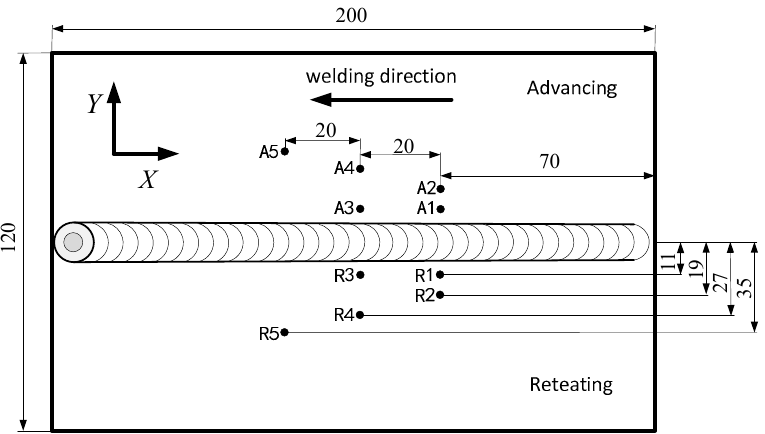
Figure 5. Temperature measurement point distribution on the workpiece.